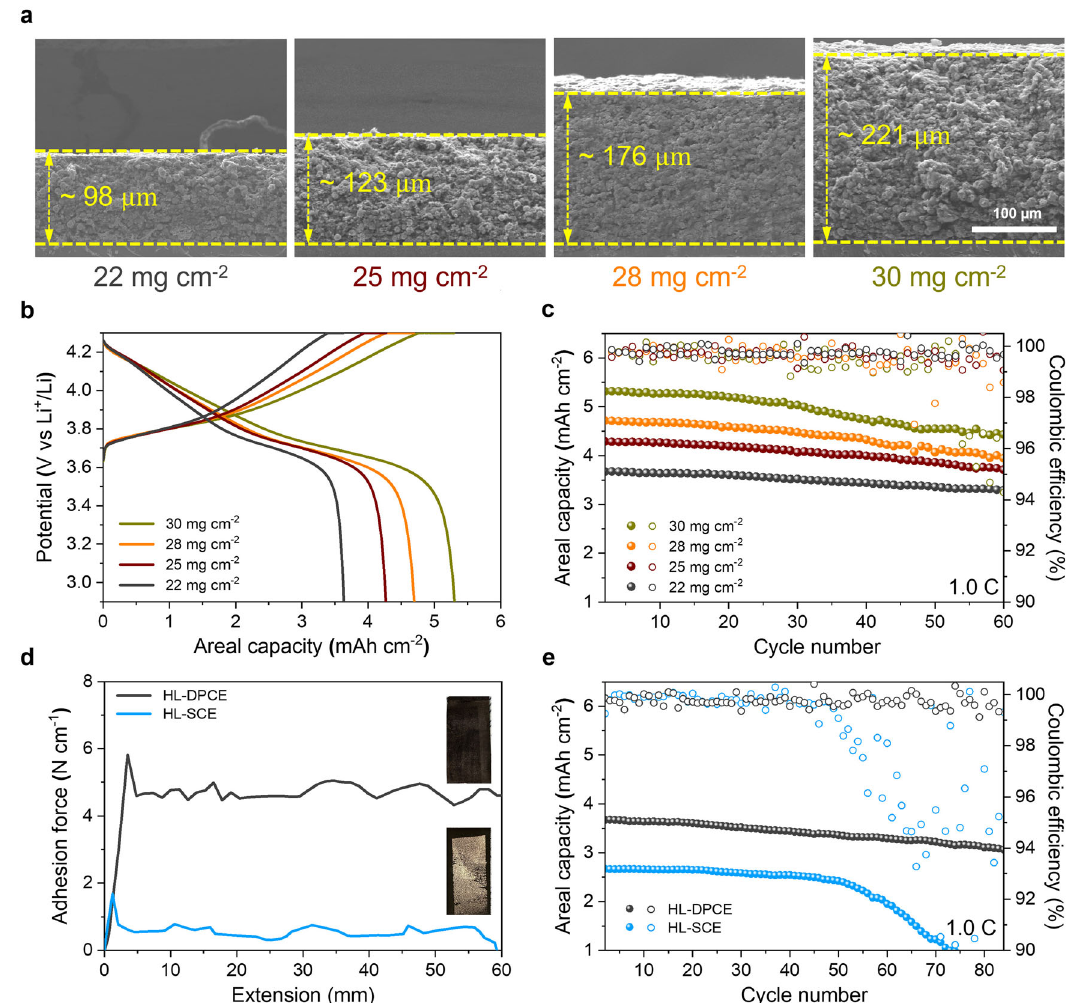
Fig. 5 | The high mass loading DPCEs (coin cells). a Cross-section SEM images of the DPCE with varying mass loadings and their corresponding thicknesses. b Charge/discharge voltage pro fi les (in terms of areal capacities). c Cycling per- formance of the DPCE with different areal mass loadings at a charge/discharge current density of 1.0/1.0C at a voltage range of 2.9 – 4.3V. d Adhesion force ofthe